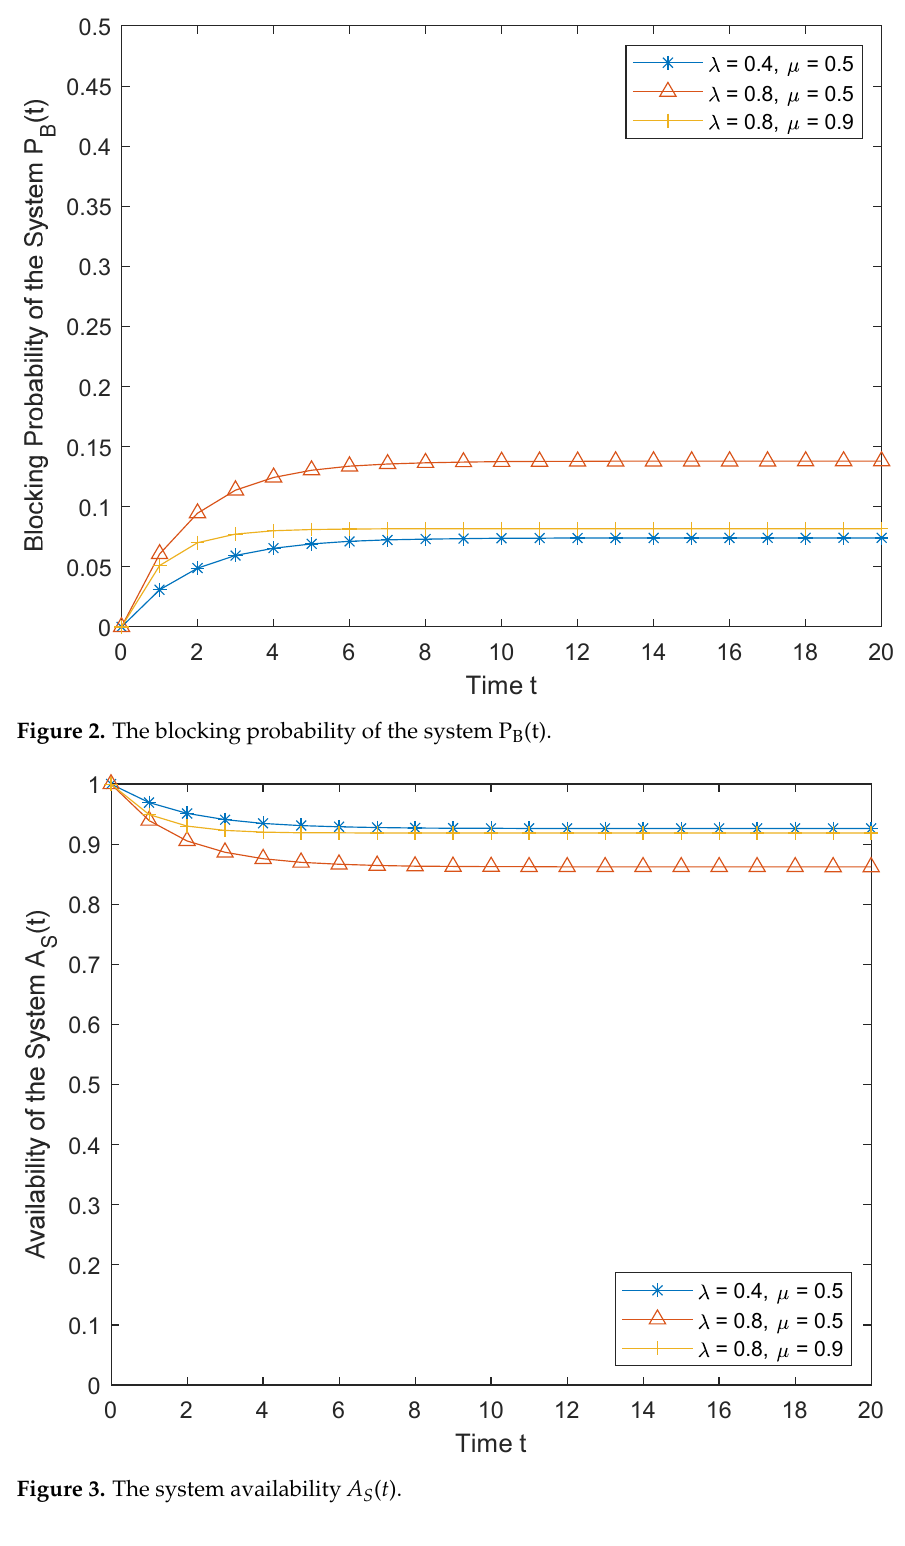
Prob. distribution of bulk arrivals Figure 2 shows how the transient solution of the blocking probability P B ( t ) changes with respect to time t and the arrival and service rates λ and μ . The probability P B ( t ) will gradually increases and then tend to stabilize as the time goes. This is reasonable as more places are initially available for the arriving customers and gradually become less and less. We also observe that P B ( t ) will increase when the arrival rate ( λ ) or the service time